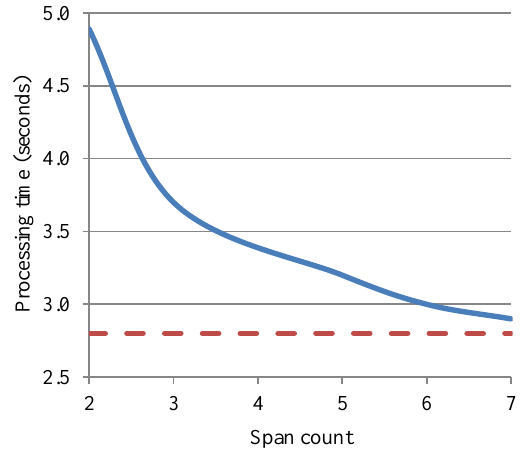
Figure 6 Count of spans in a segmentor window versus processing time. The solid line shows the processing times for segmentation with varying span counts. The dotted line shows the processing time for a static